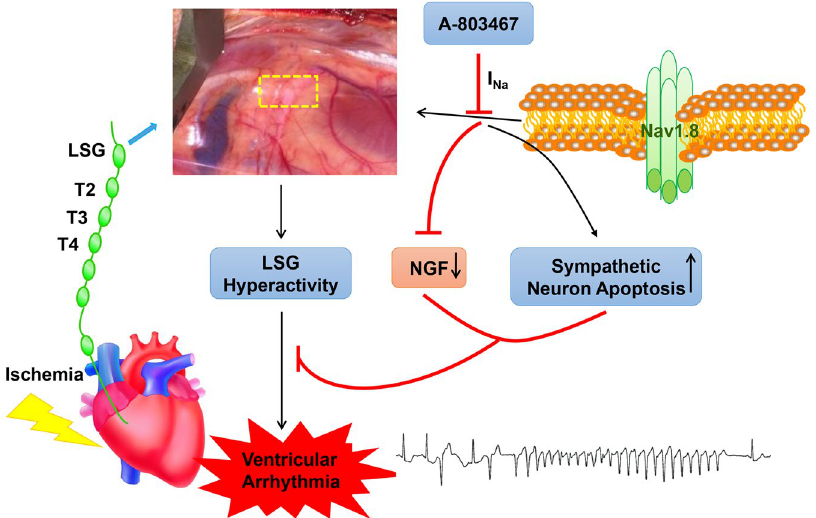
Figure 7. Schematic diagram depicting the potential role of Nav1.8 channel in LSG and VA. LSG hyperactivity contributes to the VA under acute ischemia stress. Whereas, blocking Nav1.8 channel with its specific blocker A-803467 could inhibit LSG activity through decreased NGF expression and increased sympathetic neuron apoptosis, which subsequently attenuates ischemia induced